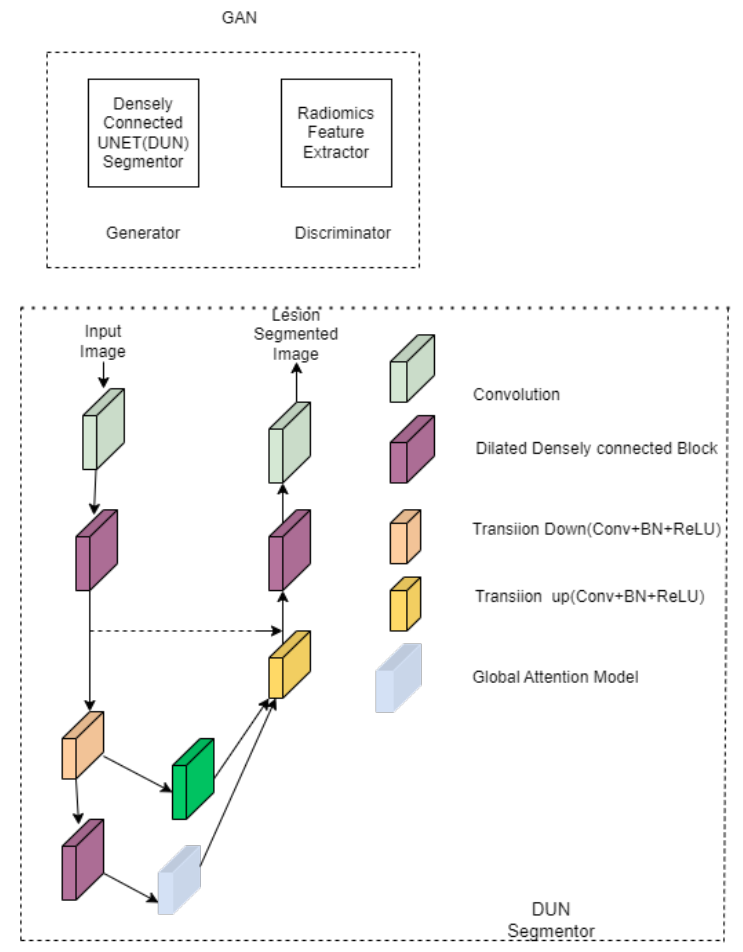
Figure 17. Densely connected UNET.